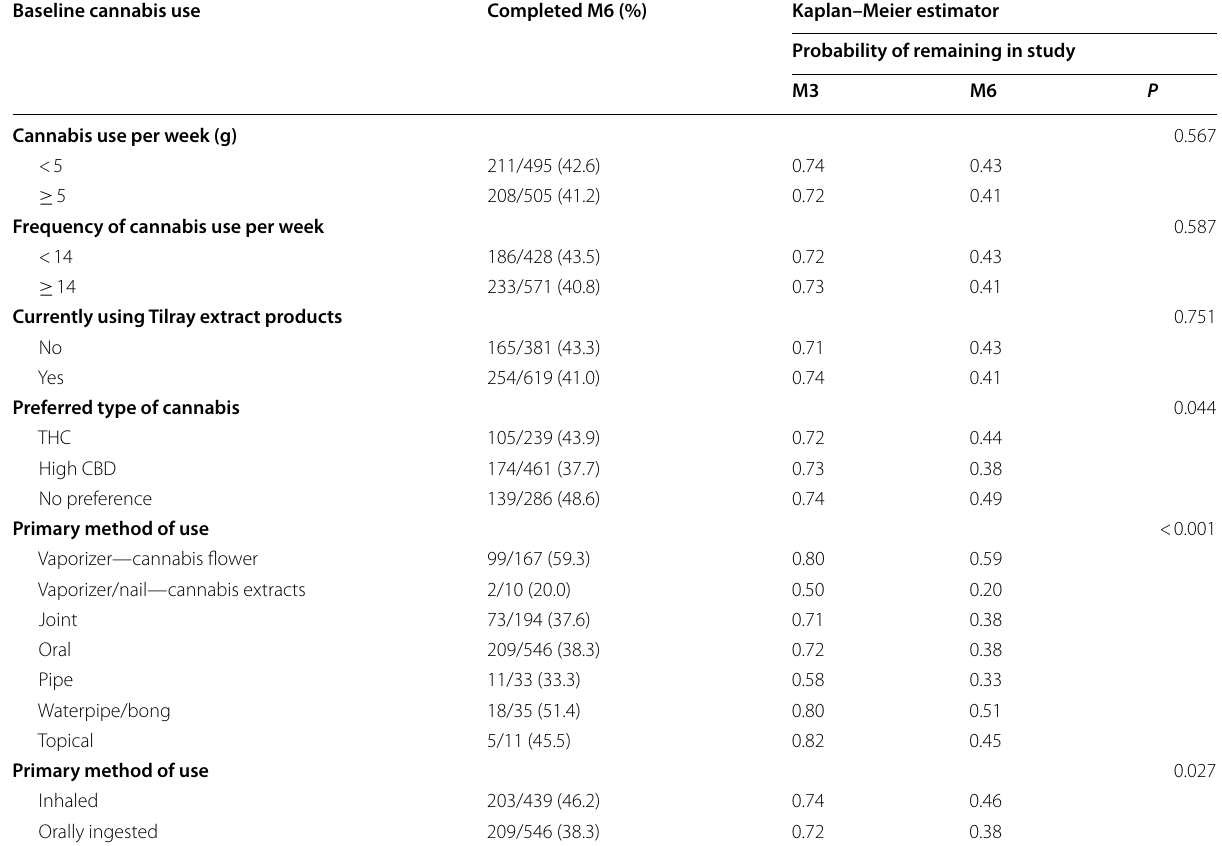
Table 3 Percent completing M6 and probability of retention at M3 and M6 by baseline medical cannabis use in 1011